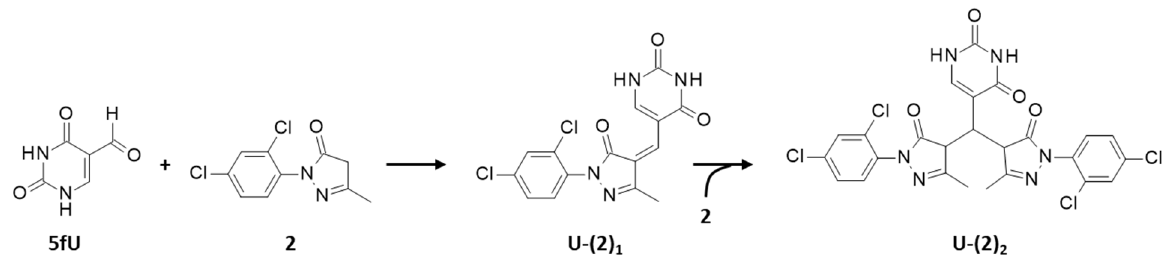
Figure 4. Reaction scheme for the formation of mono- and bis-adducts in the presence of compound 2 and 5-formyluracil (5fU). Table 3. HRMS data for the reaction of the studied products with 5-formyluracil (5fU).